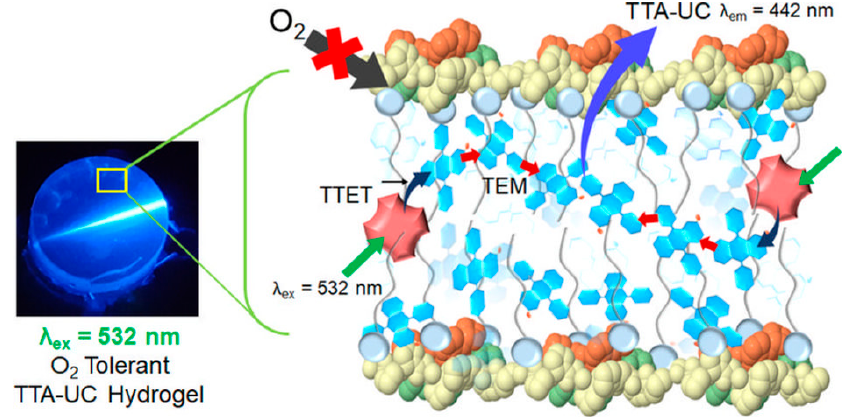
Figure 8 . A picture and schematic representation of photon-upconverting hydrogel. Donor (PtOEP) and acceptor (DPAS) molecules are accumulated in the non-polar domains of gelatin-TX100 hydrogel. The donor molecules are excited by long-wavelength light, followed by a sequence of TTET from the donor to the surrounding acceptor, TEM and TTA among the acceptor molecules, and delayed fluorescence from the upconverted singlet state of the acceptor. Adopted with permission from [43]. Copyright 2018 American Chemical Society.